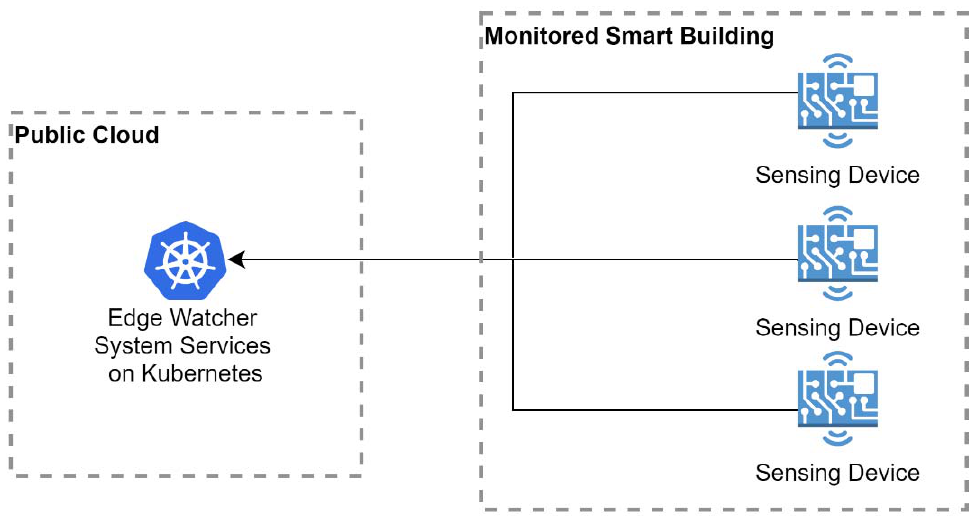
Figure 1. The EWS with a public cloud Kubernetes cluster.